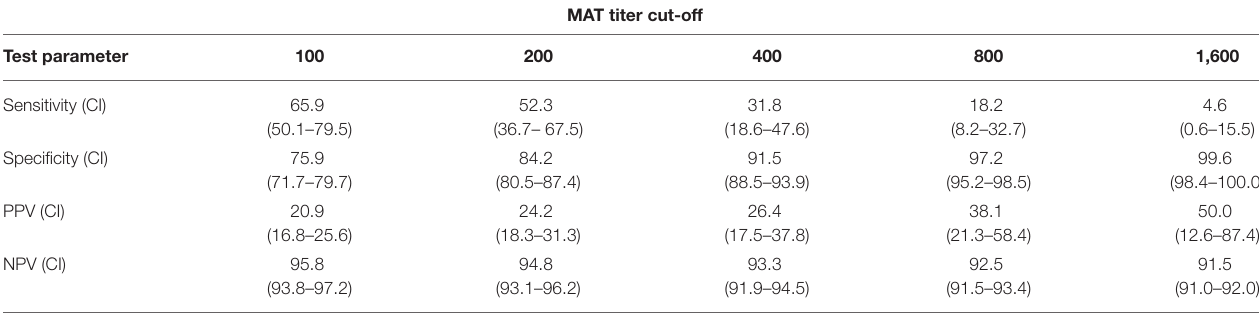
TABLE 4 | Performance of the MAT against the lipL32 qPCR assay at various titer cut-offs.